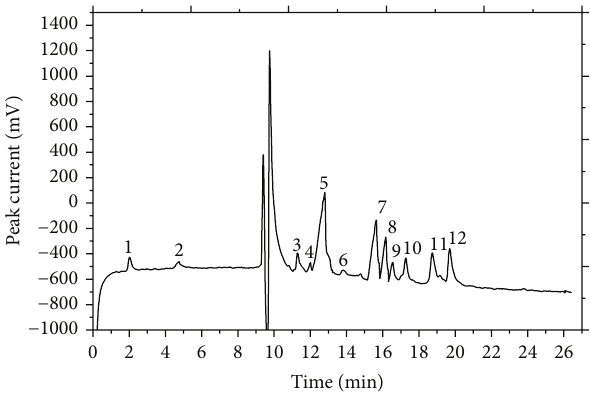
Figure 1: Standard fingerprint for chrysanthemum buds obtained from CE with the carbon working electrode. Peak 5: chlorogenic acid; Peak 6: luteolin. Working potential is 0.95 V (versus SCE); running buffer: Na 2 B 4 O 7 -NaOH (pH 11.25, 3.1 × 10 −3 g mL −1 boric acid ions); separation voltage: 14 kV, inject time: 8 s.